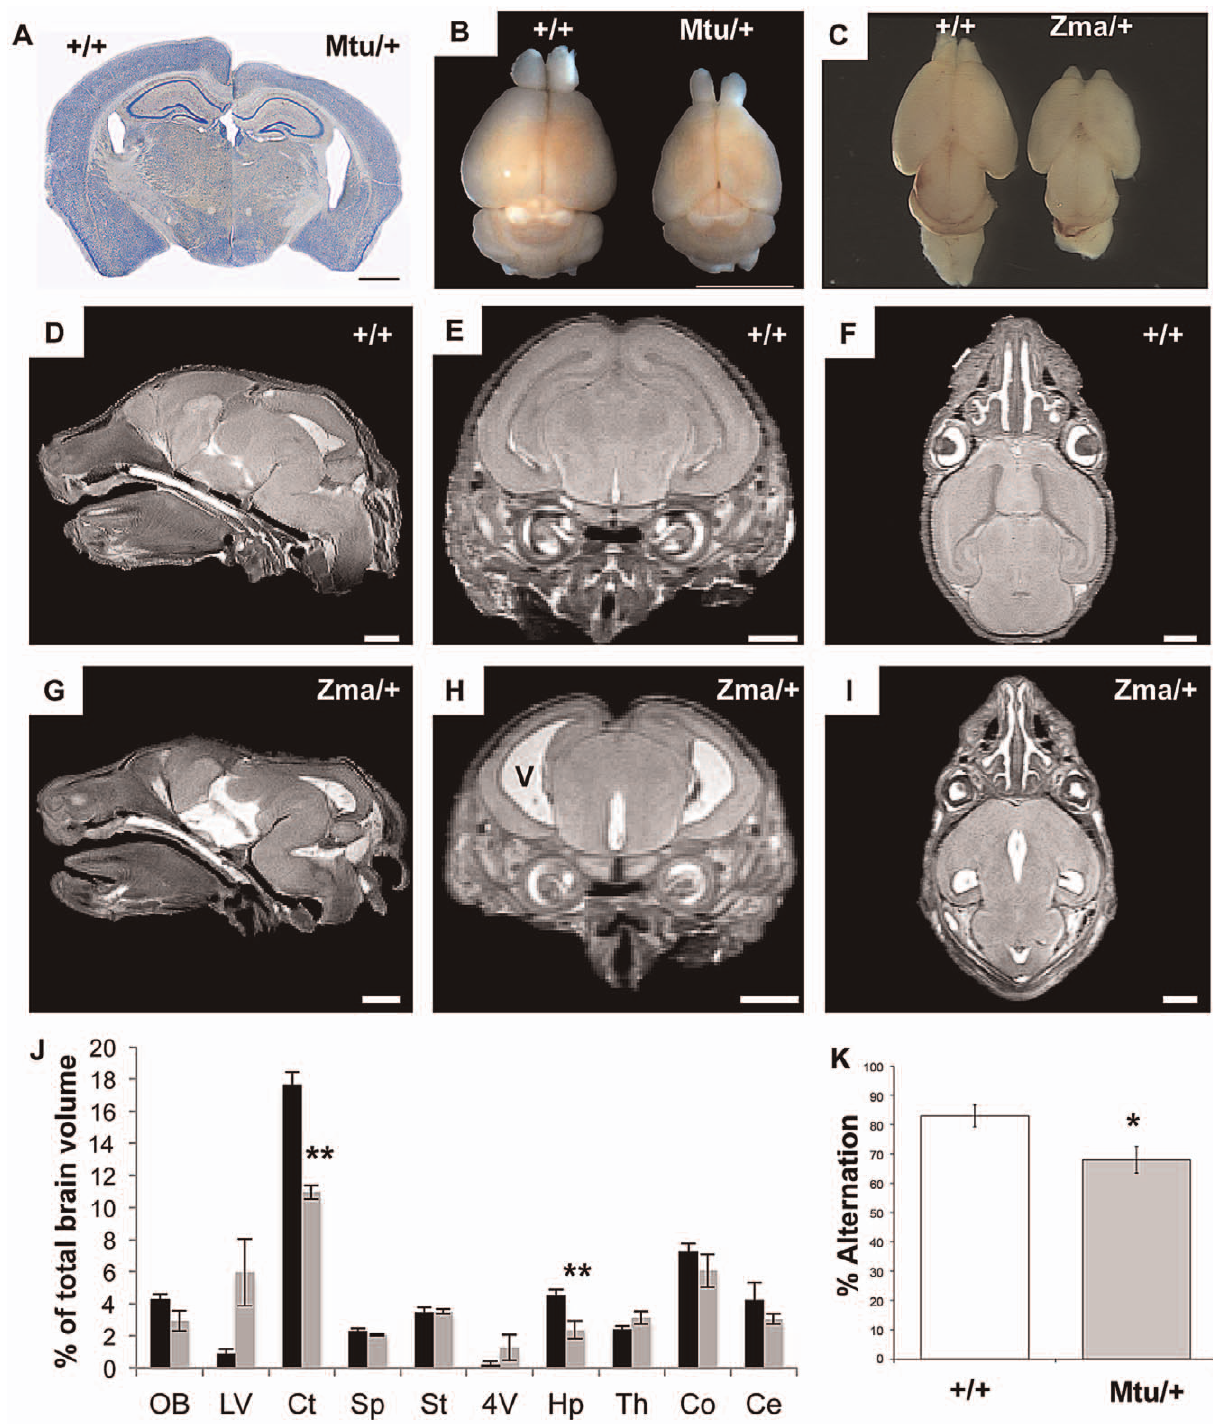
Figure 7. Brain size and behavioral abnormalities in Rps7 mutants. (A) A Nissl stained coronal section of a 5 month old Rps7 Mtu / + brain shows a thinner cortex and larger ventricles when compared to an Rps7 + / + littermate. (B, C) Dissected whole brains show that the cortex is reduced in size in adult Rps7 Mtu / + (B) and postnatal day 0 Rps7 Zma / + mice (C) when compared to Rps7 + / + littermates. (D–I) Magnetic Resonance Microscopy (MRM) was used to visualize brain development in late gestation (E18.5) Rps7 + / + (D–F) and Rps7 Zma / + (G–I) embryos. Enlarged ventricles (v in panel H) were apparent in all Rps7 Zma / + samples (N=3). Representative slices are shown in sagittal (D,G), coronal (E,H), and axial (F,I) views. Scale bars=1 mm. (J) The volume of each brain region was quantitated as a percentage of total brain volume in Rps7 + / + (black columns) and Rps7 Zma / + (gray columns) (N=3). Abbreviations: Olfactory bulbs (OB), lateral ventricles (LV), cortex (Ct), septum (Sp), striatum (St), 4 th ventricle (4V), hippocampus (Hp), thalamus (Th), colliculi (Co), cerebellum (Ce). ** indicates p , 0.005. (K) Assessment of working memory by measuring spontaneous alternation in a T- maze showed a significant difference between Rps7 Mtu / + mice and Rps7 + / + littermate controls (* indicates P=0.01, N=9). In all panels + / + = Rps7 + / + ; Mtu/ + = Rps7 Mtu / + ; Zma/ + = Rps7 Zma / + .